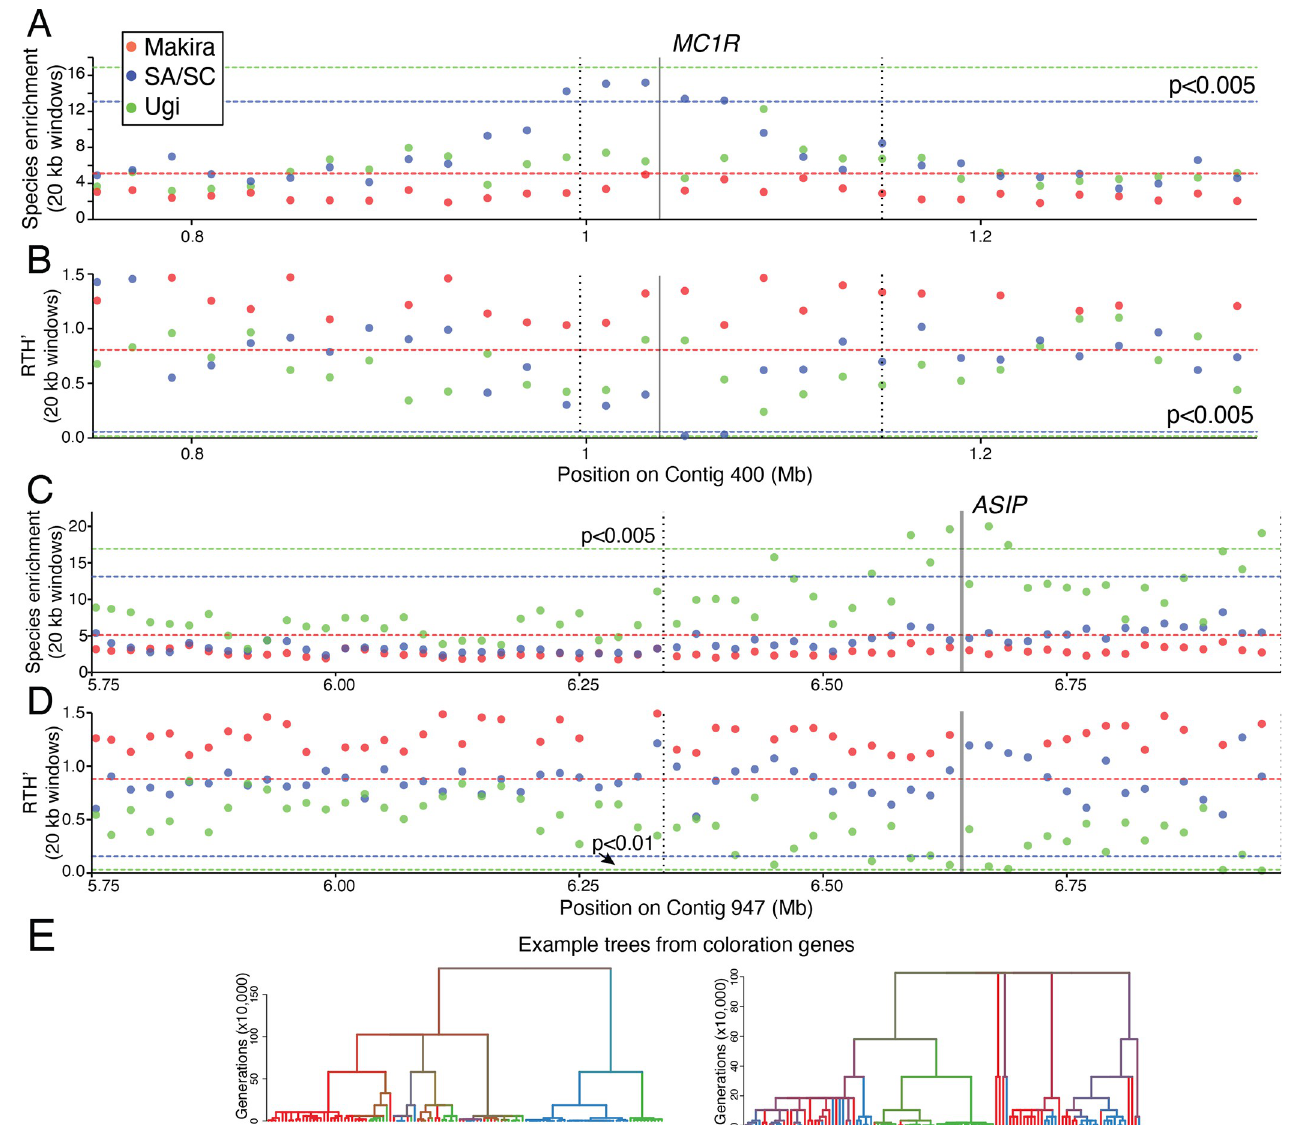
Fig 4. Signatures of selective sweeps in ARG-based statistics on the focal contigs with coloration genes. Plots showing species enrichment ( A , C ) and RTH’ ( B , D ) in 20 kb windows along contig 400 and 947. Horizontal lines show species-specific levels of statistical significance, dashed vertical lines define the regions of the association peaks, and solid vertical lines show the position of coloration genes ( MC1R and ASIP ). E . Outlier values of species-enrichment within the MC1R and ASIP genes (the position on the contig from which each topology is derived is shown on the bottom of each tree). The terminal branches are color-coded by island and the color of internal branches represents an average over all offspring